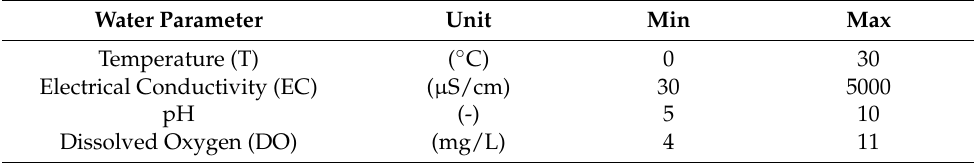
Table 3. Physiochemical parameters recorded in Greek rivers and their permissible limits. Water Parameter